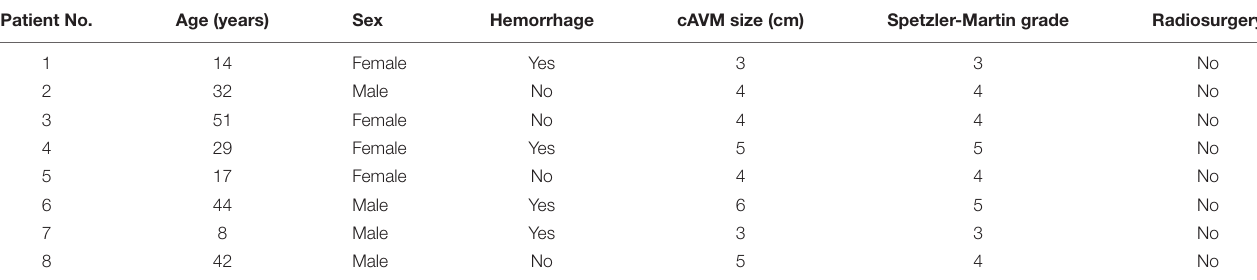
TABLE 1 | Clinical data of cerebral arteriovenous malformations patients who underwent microsurgical cAVMs resection. Patient No.